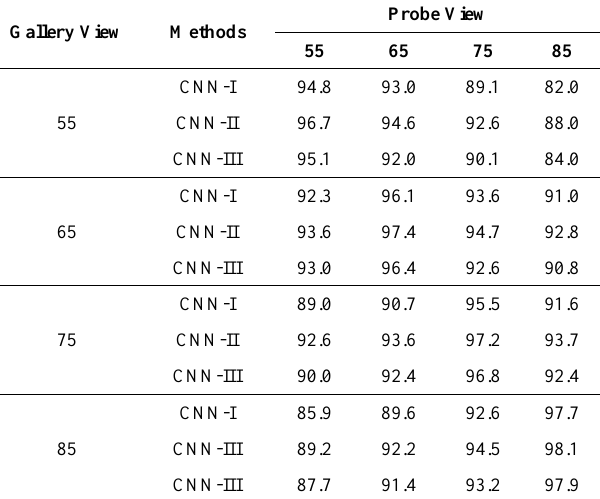
Table 2. Correct Classification Rate for OUISIR-LP Dataset Gallery View